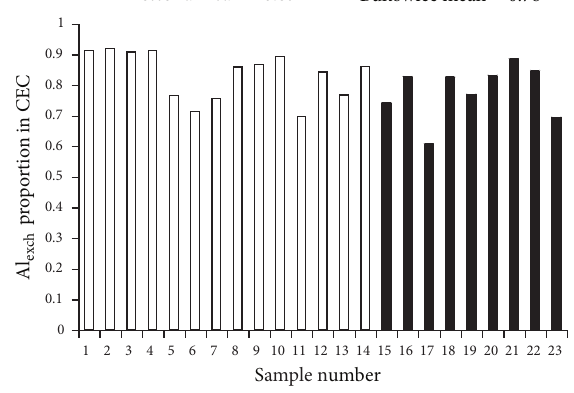
Figure 1: Aluminium proportion in